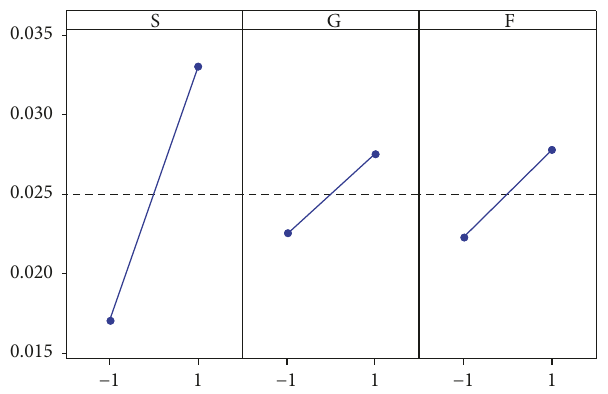
Figure 6: Diagram of the main effects for absorbance (S: sucrose; G: glucose; F: fructose).